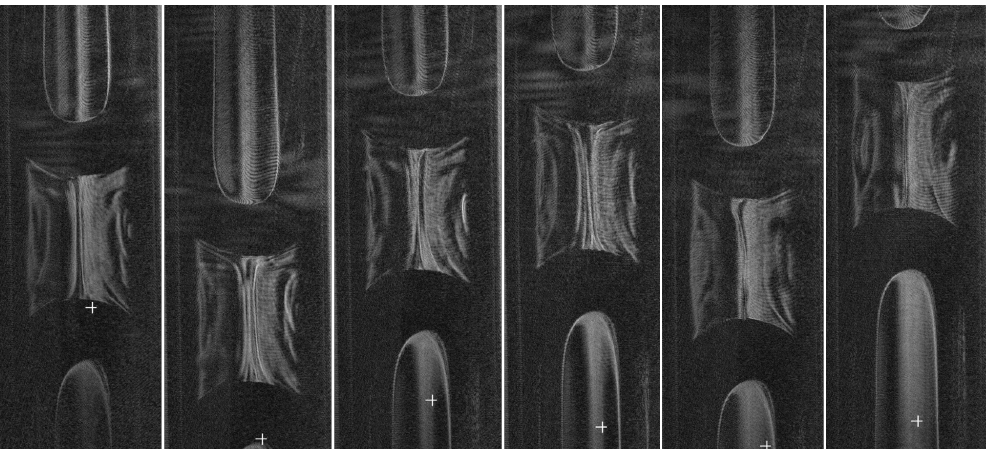
Figure 8. The reconstructed holograms from the experiments with CO 2 absorption in caustic soda showing the mixing and turbulence of the chemical compounds.